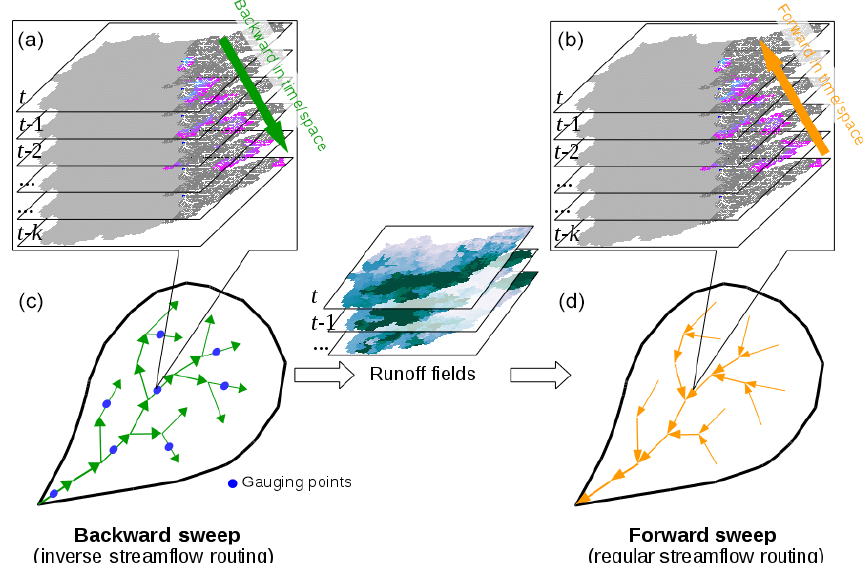
Figure 1. Two-sweep procedure for spatiotemporal assimilation–interpolation of discharge records. The first sweep (c) propagates observed information collected at gauging points upstream and backward in time following the inverse streamflow routing method developed in Pan and Wood (2013) and derives continuous runoff fields (lateral influx at furthest possible upstream). The second sweep (d) propagates information downstream and forward in time (regular routing) to create continuous discharge values everywhere. The stacked spatial maps at the top illustrate how the observed information at a single point in time–space propagates backward in time–space (a) and how discharge is reconstructed from the integrated runoff (b)